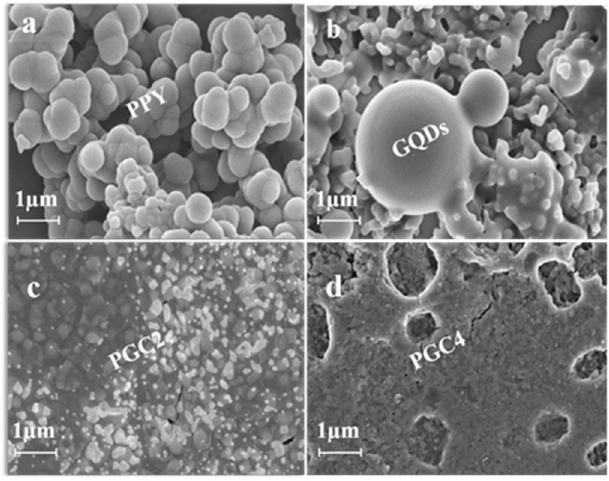
Figure 4. FESEM images of ( a ) PPy, ( b ) GQDs, ( c ) PGC2, and ( d ) PGC4.